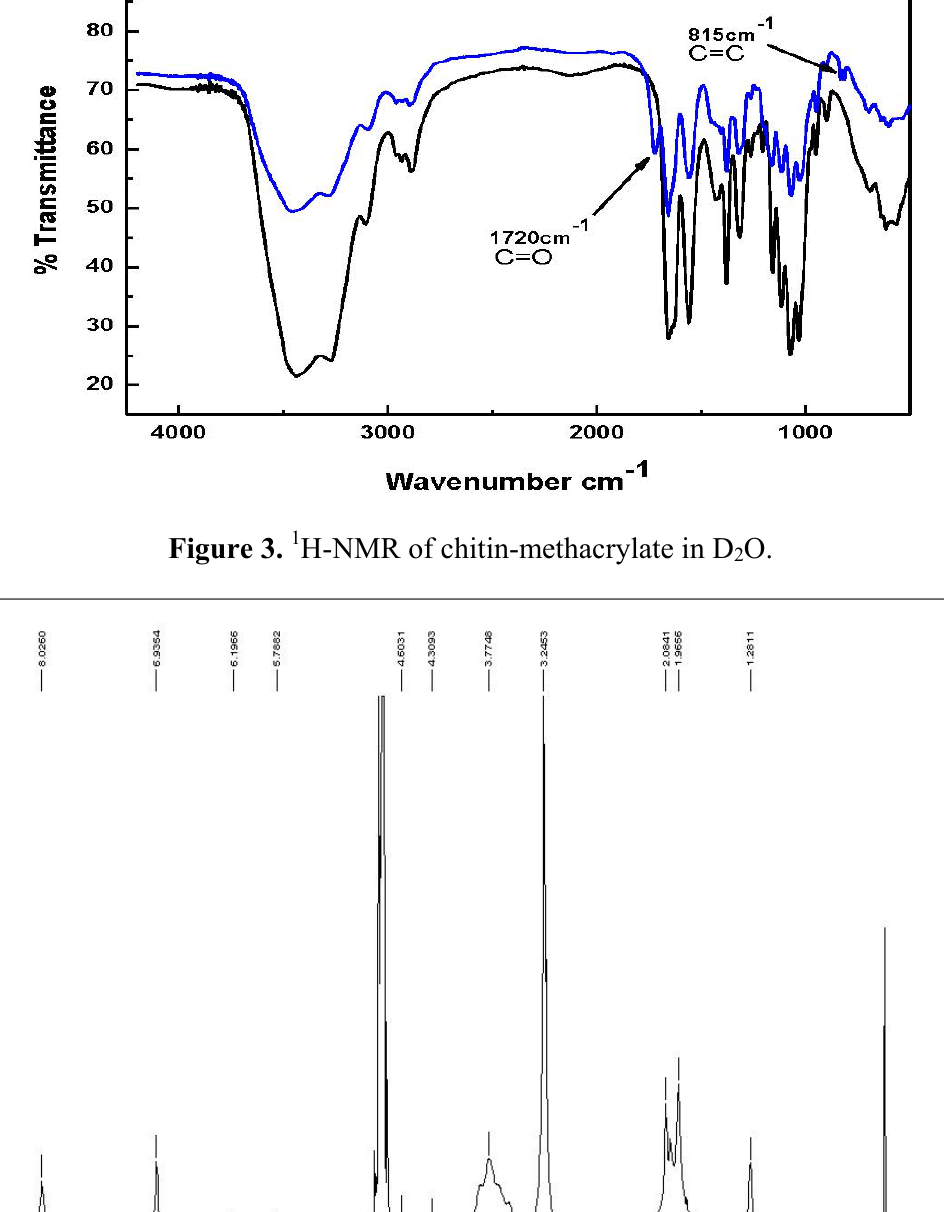
Figure 2. FT-IR spectra of low molecular weight chitin and chitin-methacrylate Top spectrum: Chitin-Methacrylate (CM); Bottom spectrum: Low molecular weight chitin.